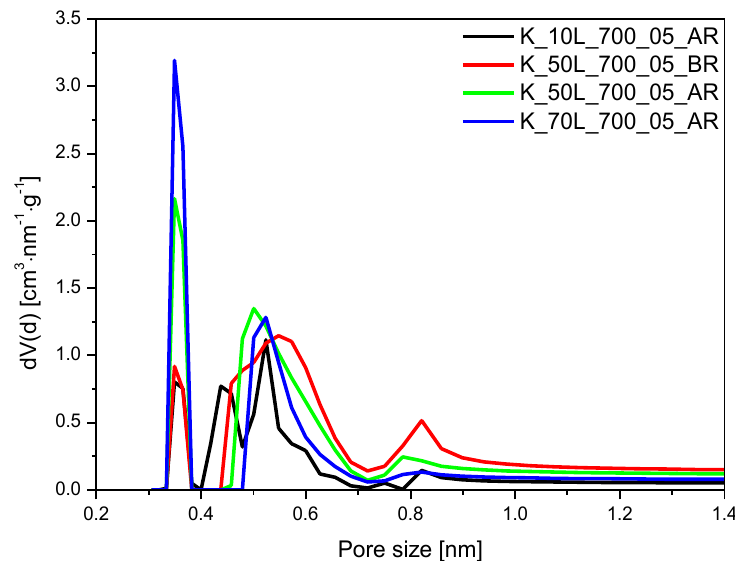
Figure 10. PSD of the samples activated with KOH and added at different preparation steps.